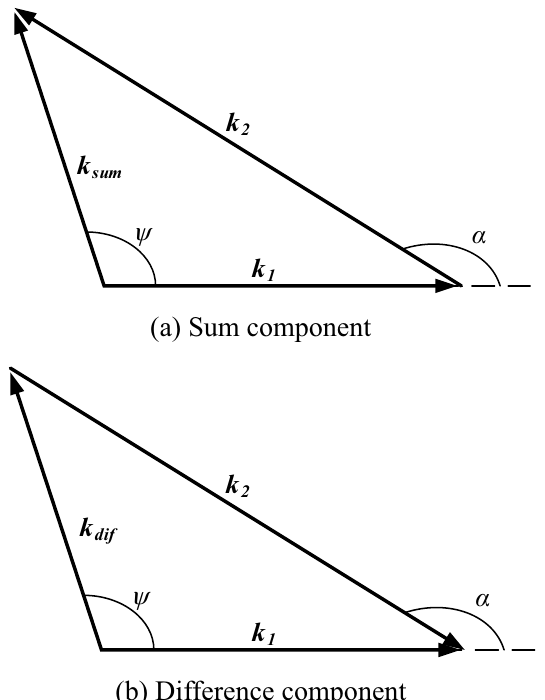
Figure 2 Resonant conditions in aluminum plate for interaction of two A0 waves to generate S0